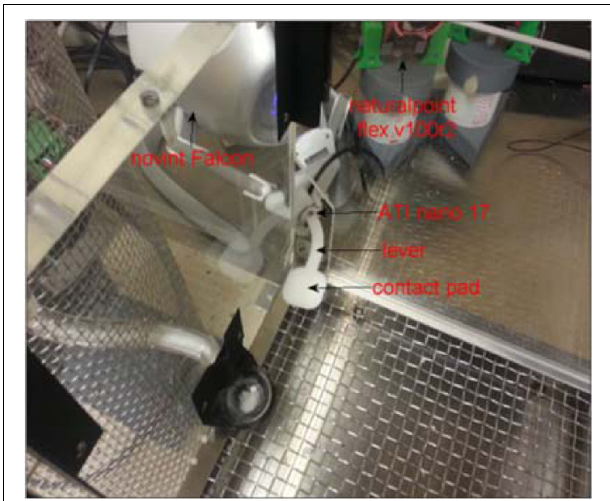
FIGURE 3 | A photo of the Falcon haptic manipulator with the force sensor and custom-design lever installed into a transparent training box. The picture shows the corner of the box from inside where a window was opened and the lever arm was brought in through the window. The rats were trained to push down on the contact pad with their preferred hand. The lever is switched to the opposite side of the box for a left-handed animal.